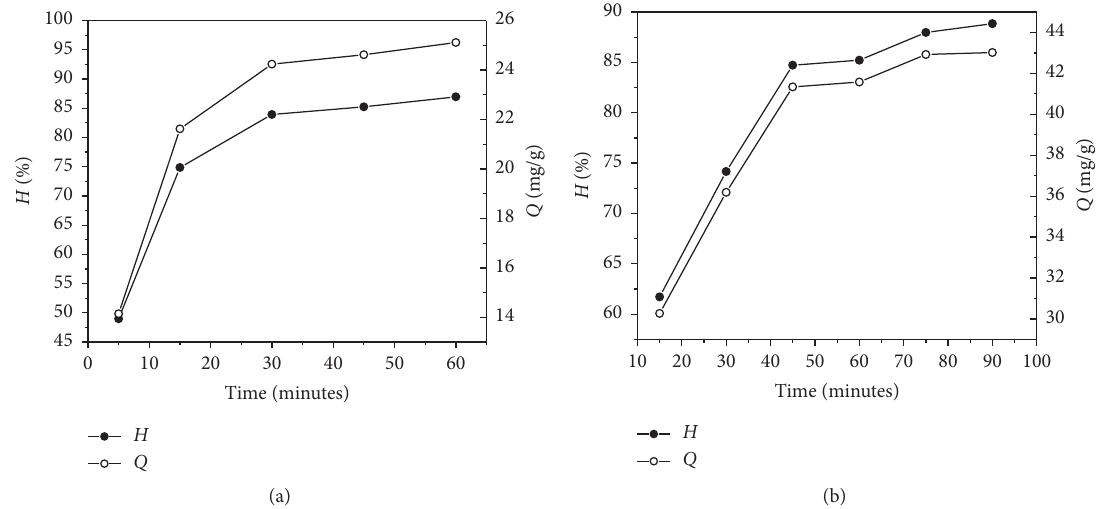
Figure 10: Variation of Cd 2+ (a), Cu 2+ (b) adsorption capacity, and efficiency of modified apatite ore according to the contact